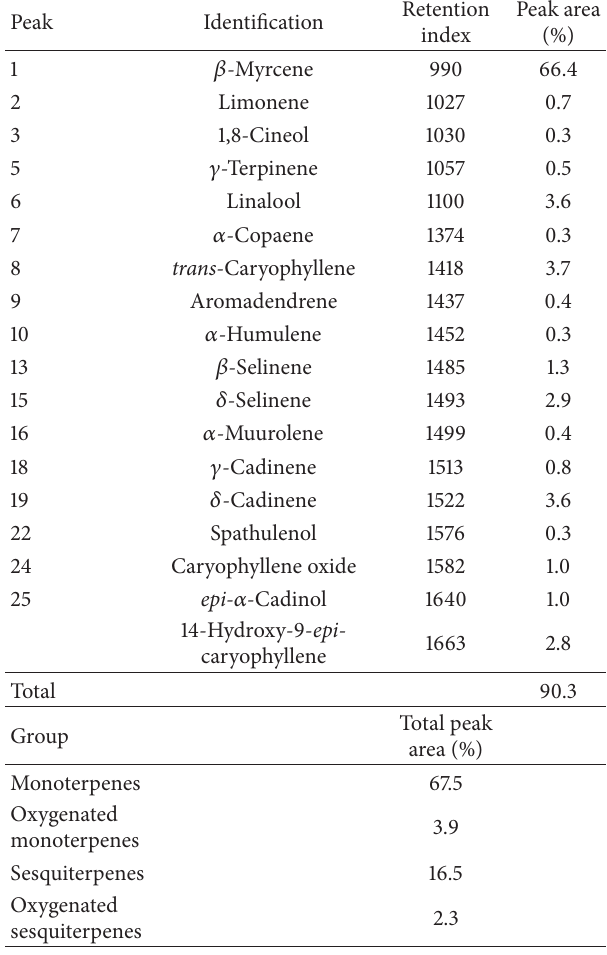
Table 3: Myracrodruon urundeuva EOs chemical compounds, retention indices, and relative peak